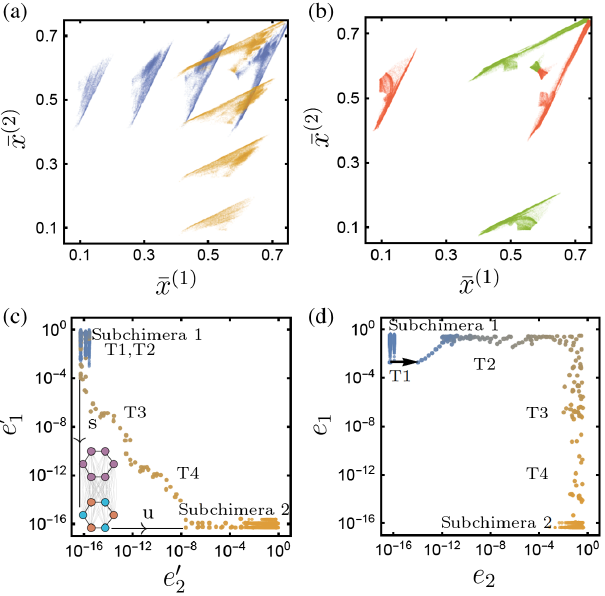
FIG. 5. Projections of invariant sets and transition paths. (a) Symmetric subchimeras when projected onto the mean state of each ring. Each subchimera is indicated by a different color. (b) Invariant saddle in Fig. 4 (and its symmetric counterpart) projected onto the mean state of each ring. (c) Transition path with an action of 10 − 28 projected onto coordinates e 0 1 and e 0 2 . Under this projection, the invariant saddle is projected onto the lower left corner. The stable and unstable manifolds of the invariant saddle are marked by s and u, respectively. The path starts at the blue subchimera in the upper left corner and ends at the orange subchimera in the lower right corner. (d) Same transition path as in (c) projected onto e 1 and e 2 . The perturbation that initiates the transition is marked by an